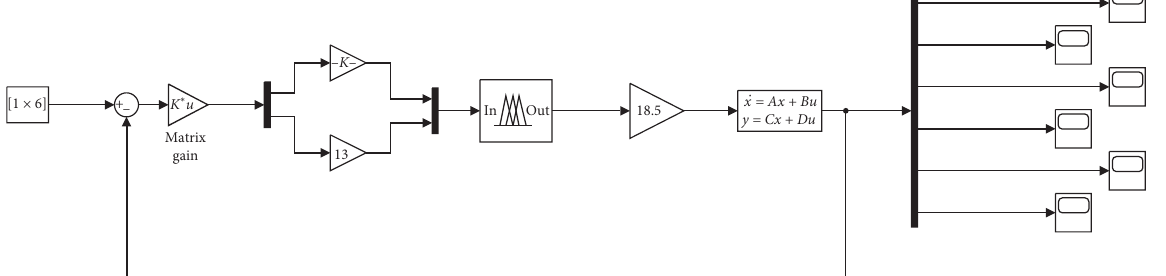
Figure 4: Control block diagram of the double inverted pendulum.